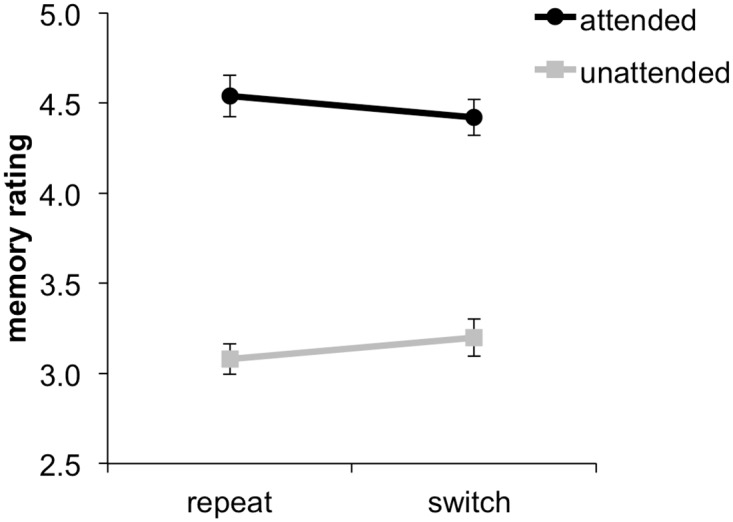
Memory ratings for attended and unattended items presented during repeat and switch trials.Error bars indicate standard errors of the mean.